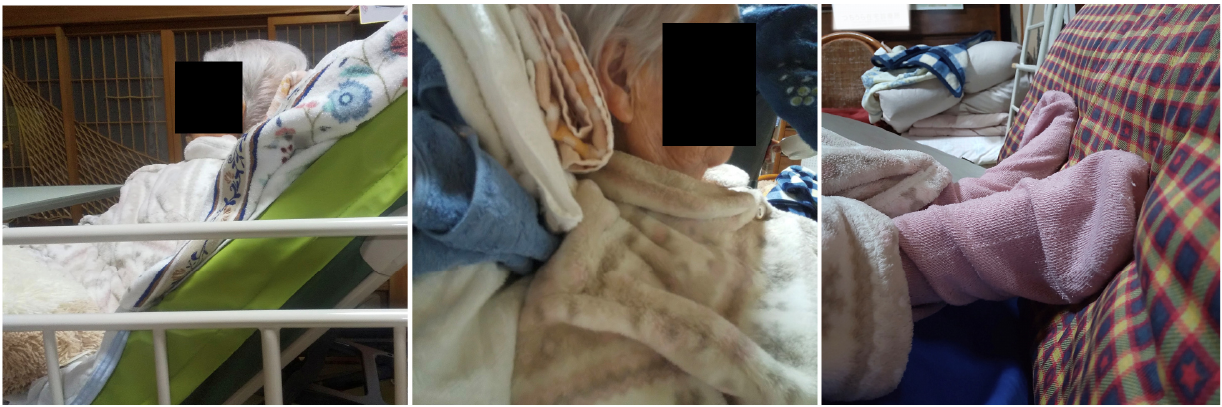
Figure 3. Side view ( left ), neck region ( middle ), and foot region ( right ) of the patient after postural regulation.